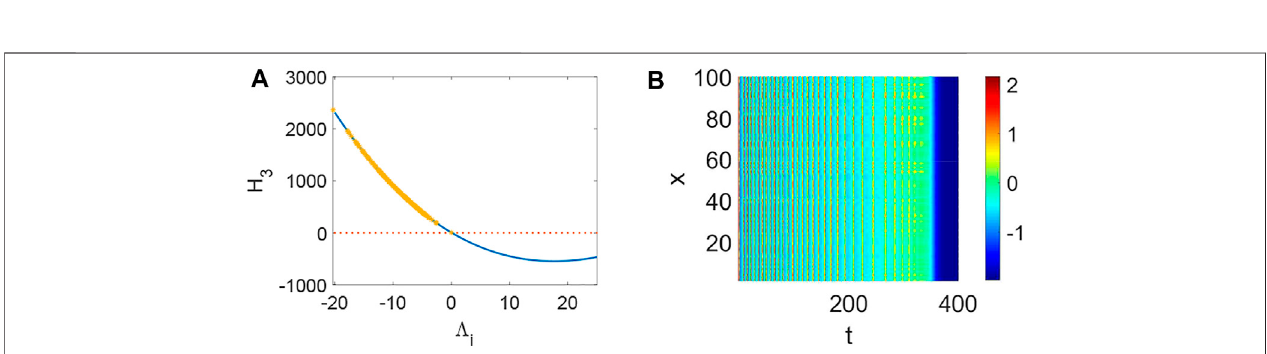
FIGURE 5 | The stability of system (1) when p = 0.1, q = 0, τ = 0. (A) The distribution of eigenvalues Λ i (labeled by *). (B) The corresponding pattern formation is stable in system (1) when no eigenvalue Λ i make H 3 < 0 hold.